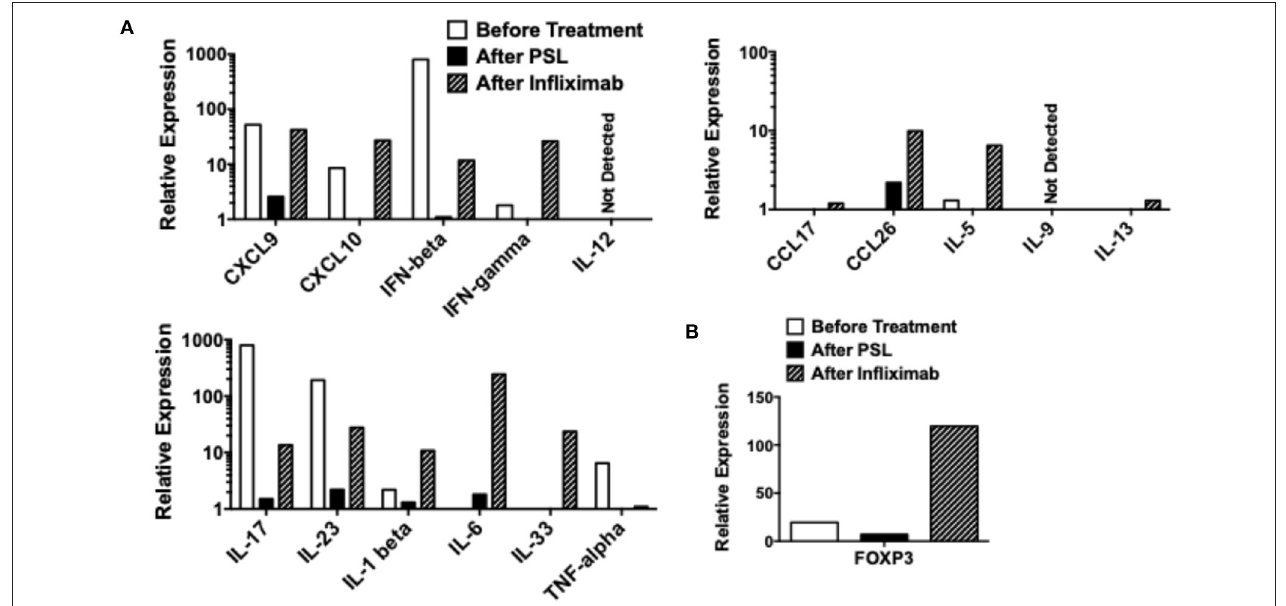
FIGURE 3 | Quantitative polymerase chain reaction analyses in colonic biopsy samples. Colonic biopsy samples were subjected to quantitative polymerase chain reaction analyses to determine expression of cytokines and chemokines. Colonic biopsy samples were obtained before the treatment (Day 7 in Figure 2A ), after the treatment with prednisolone (PSL, Day 42 in Figure 2A ), and after the treatment with infliximab (IFX, Day 98 in Figure 2A ). mRNA expression levels of cytokines, chemokines (A) , and forkhead box P3 (FOXP3) (B) were normalized by that of β -actin